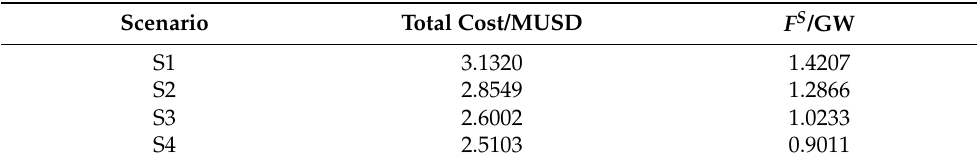
Table 2. Impact of wind power volatility and